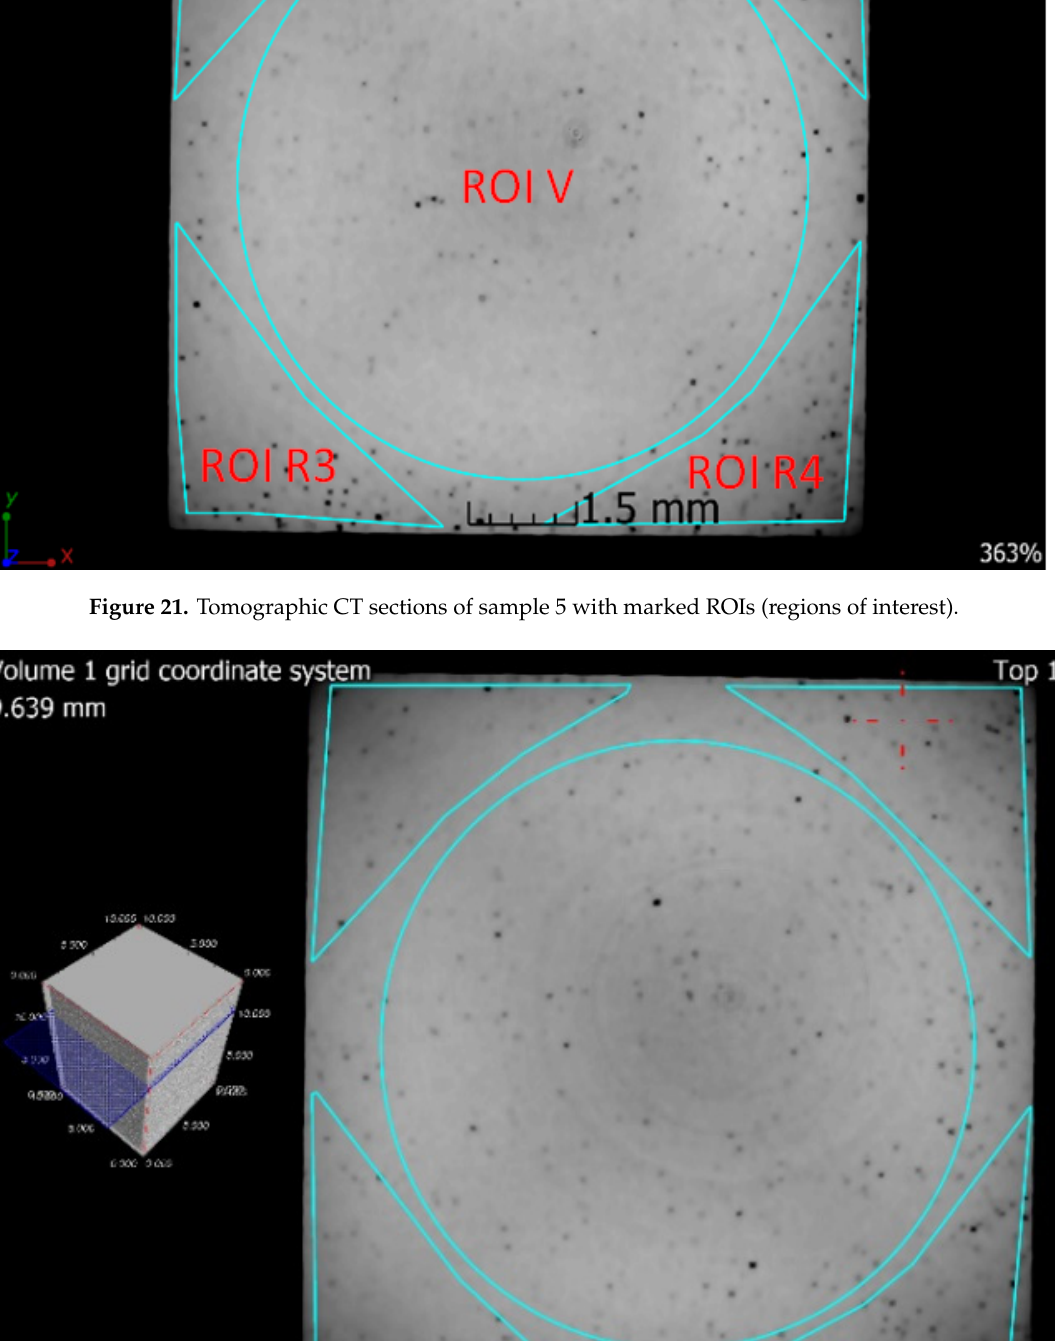
Figure 22. Segmentation and pore distribution in sample 5 after SLM.